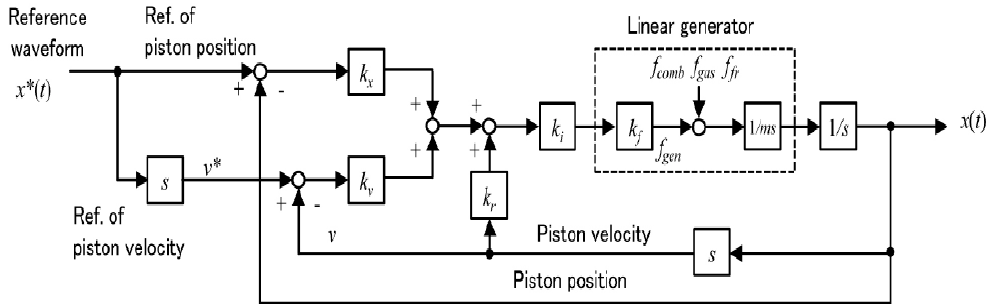
Figure 24. The control diagram of Toyota Central R&D Labs [14].